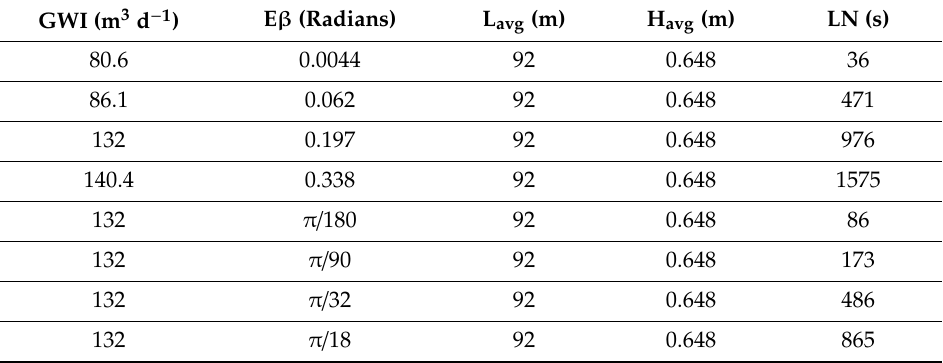
Table 7. Calculated values of leakage number to characterize overall system